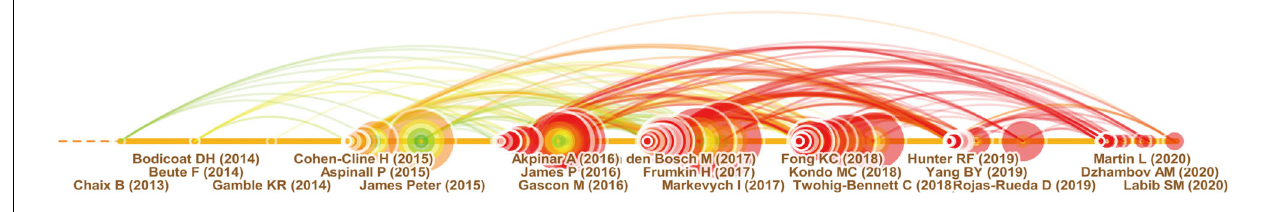
FIGURE 10 | High-impact publications in Cluster